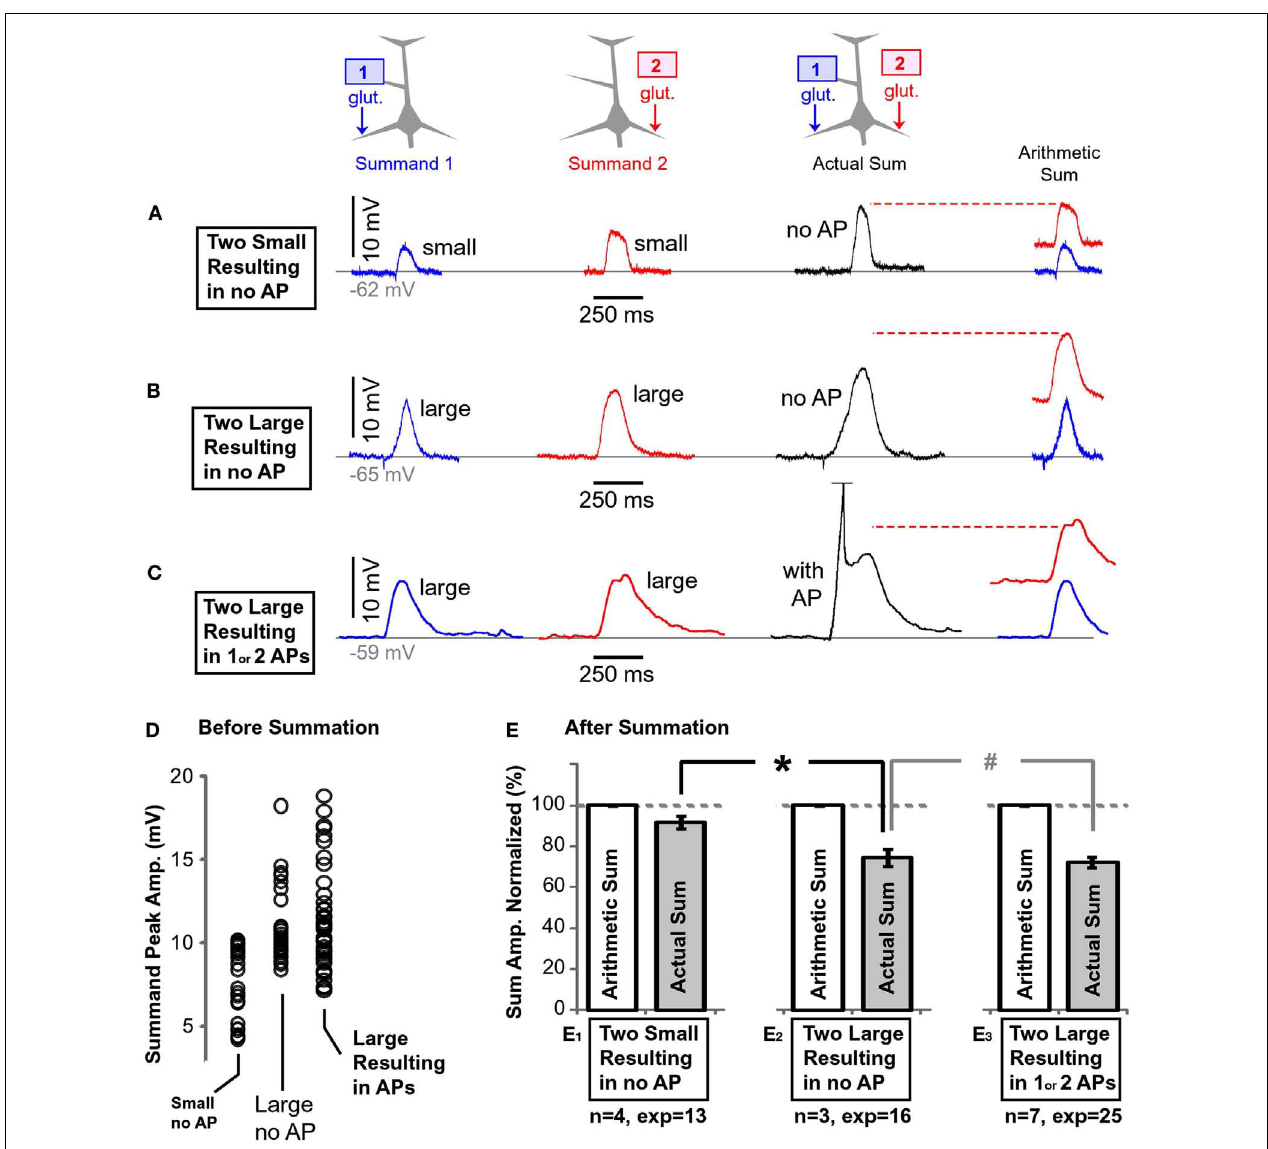
summands (blue and red) are “large,” as defined in Section “Materials and Methods.” (C) Same as in (B) except summation resulted in AP firing (truncated). (D) Peak amplitudes of each summand (before summation) separated in three groups using criteria explained in Section “Materials and Methods.” (E) The amplitude of the actual depolarization (black trace) was divided by the corresponding arithmetic sum, and averaged across all experiments within one group.The name of the data group, number of cells ( n ) and the number of experiments (exp) are shown below each pair of bars. The dashed horizontal gray line marks the expected value if summation of two dendritic plateau potentials were perfectly linear. ∗ p < 0.05 (unpaired t -test). # p > 0.05.